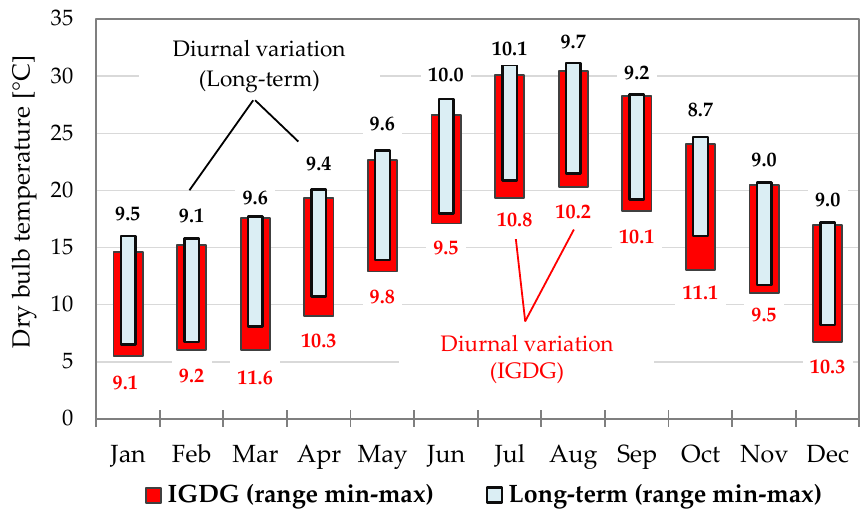
Figure 8. Monthly mean values for the daily minimum and maximum dry bulb temperatures (and corresponding diurnal temperature fluctuations).